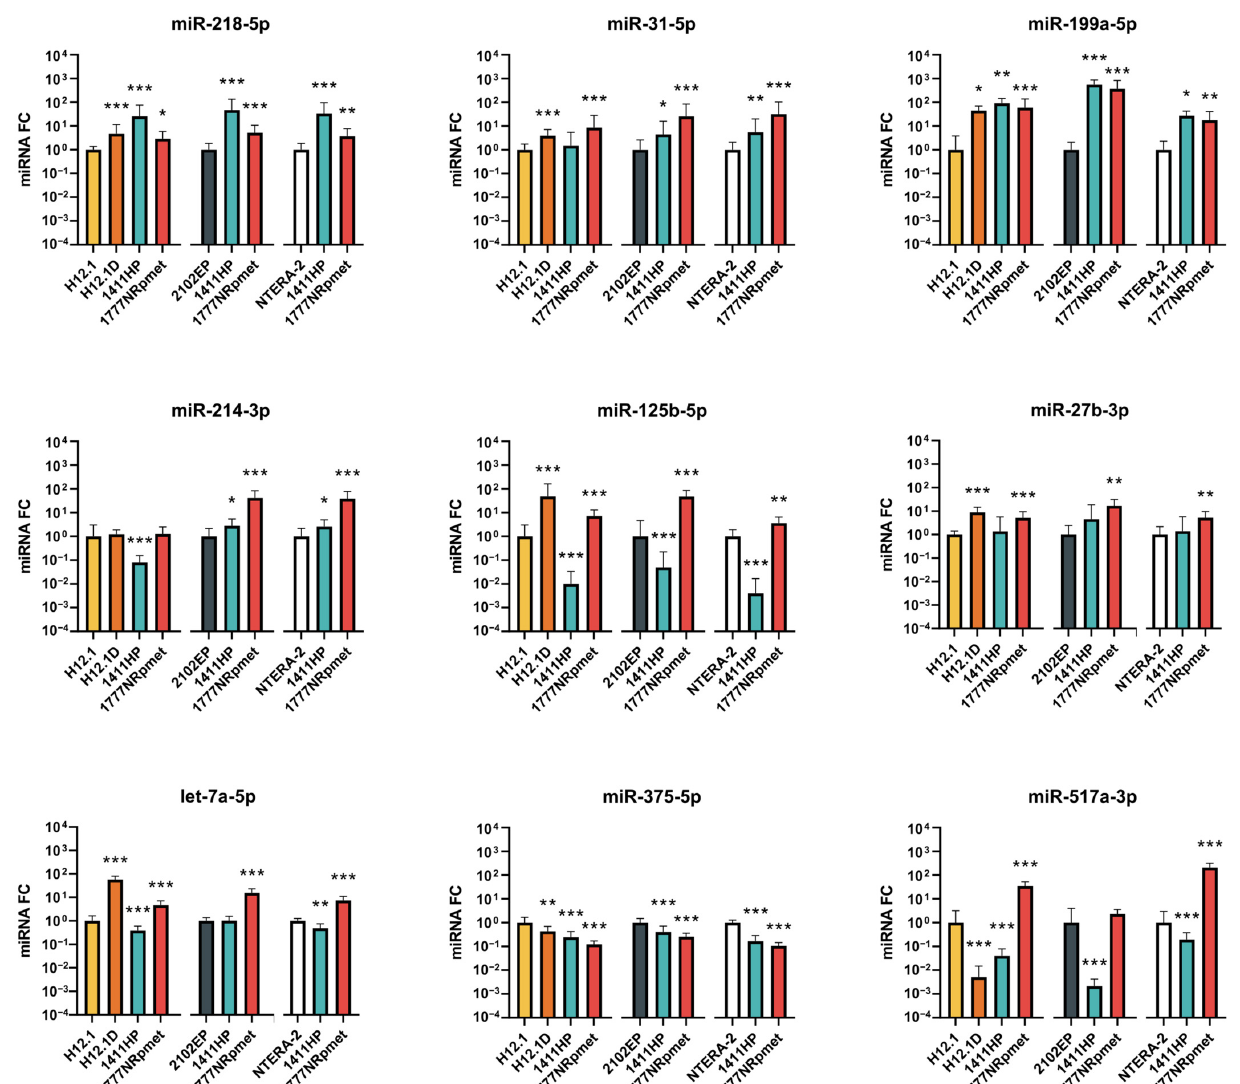
Figure 3. Expression changes of nine candidate miRNAs that were identified as up-regulated in miRNA expression array. CDDP-resistant (H12.1D, 1411HP and 1777NRpmet) and -sensitive (H12.1, 2102EP and NTERA-2) TGCT cell lines were compared. CDDP-resistant cell line H12.1D was compared only with CDDP-sensitive cell line H12.1, as it represents its isogenic pair. Data are presented as mean FC (2 −ΔΔ Ct ) of CDDP-resistant vs. -sensitive TGCT cell lines from three technical and three biological replicates. Error bars represent upper and lower limits of expression (2 −ΔΔ Ct ± SD Δ Ct ). * p ≤ 0.05, ** p ≤ 0.01, *** p ≤ 0.001.